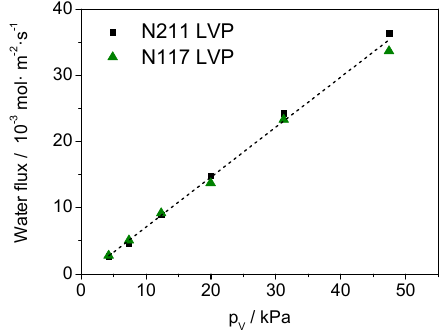
Figure 5. Water permeation flux through N211 and N117 films as a function of the water vapor pressure under liquid–vapor permeation (LVP) conditions and natural convection of air.